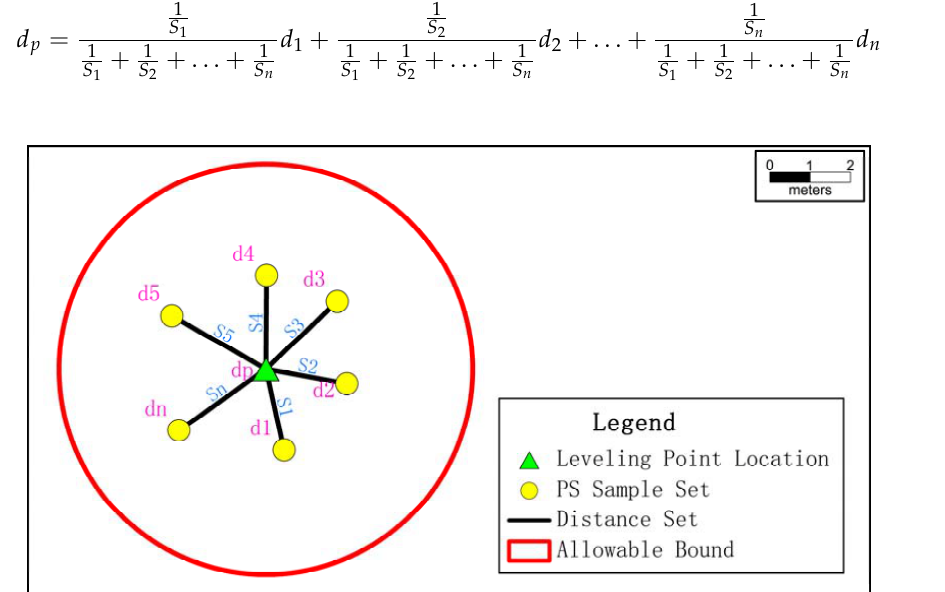
Figure 9. Inverse Distance Weighted (IDW) interpolation to obtain InSAR displacement in the location of leveling points with high ‐ density PS sample set and weights related to distance.